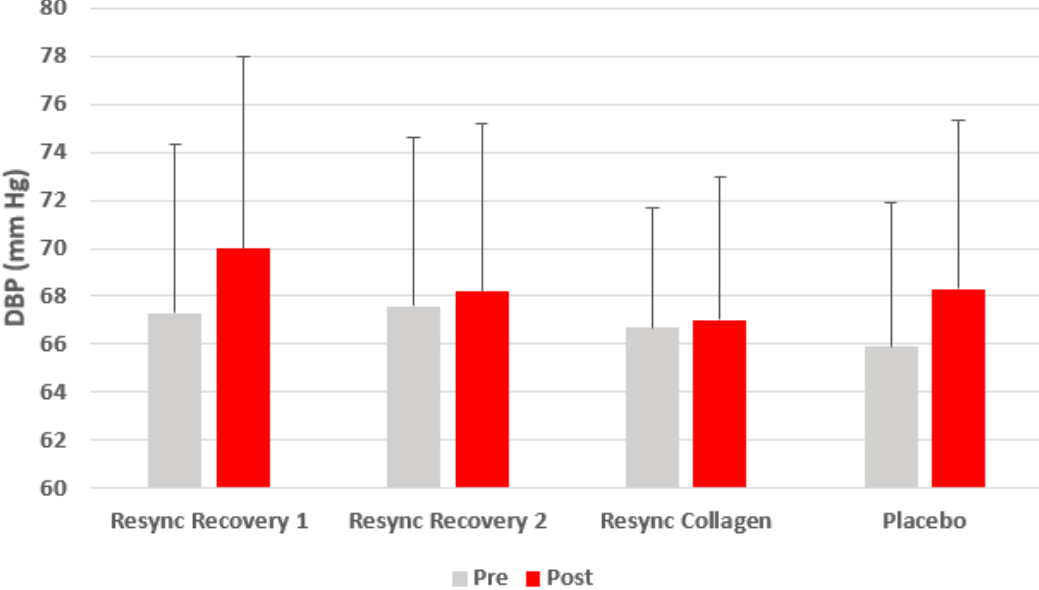
Figure 3. Diastolic blood pressure before and 75 min after ingestion of Resync or placebo. Values are the mean ± SD. No differences of statistical significance were noted ( p > 0.05). Note: Resync Recovery 1 = 1 serving; Resync Recovery 2 = 2 servings.